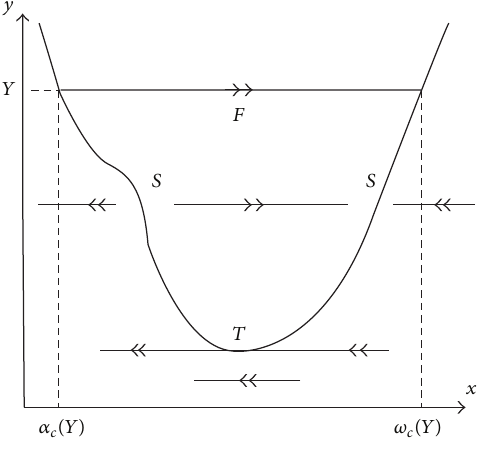
Figure 2: Canard cycle having one turning